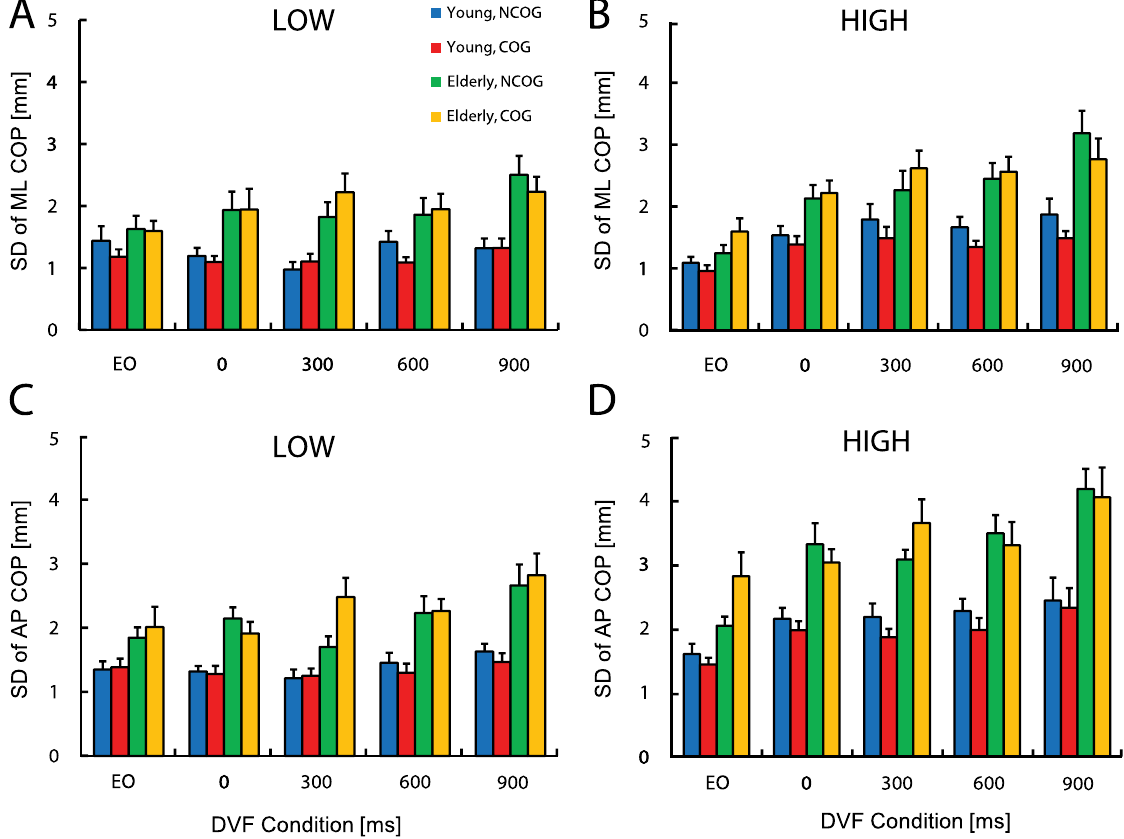
Figure 3. Summary plot of standard deviation of the LOW (left panel) and HIGH (right panel) ML (A, B) and AP (C, D) COP time series. Summary data are shown both with (COG) and without (NCOG) the cognitive dual-task for the eyes open (EO) and DVF conditions (0, 300, 600, 900 ms) in young and older participants. Error bars represent 6 1 SEM.